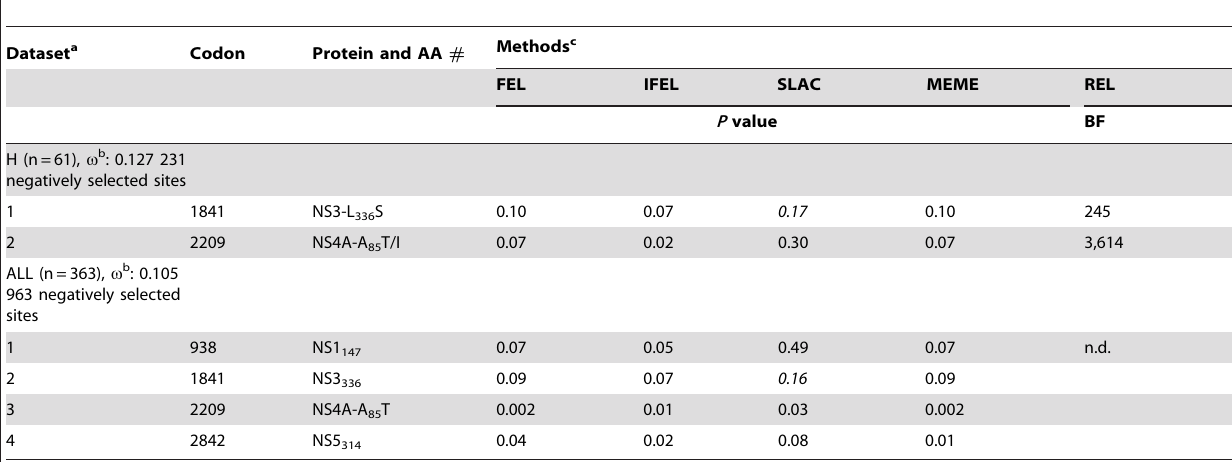
Table 3. Selection pressure analysis of WNV strains collected in the US (1999–2011), by host dataset.